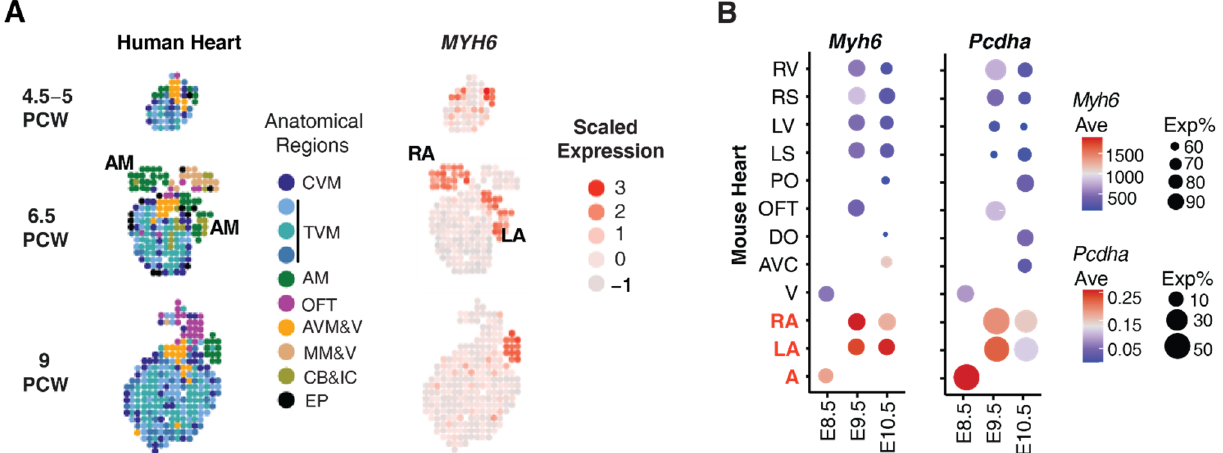
Figure 2. Atrial specific expression of MYH6 and the PCDHA gene cluster. ( A ) Spatial transcriptomic heatmap revealed abundant MYH6 expression predominantly in the atria of embryonic heart at 4.5–5, 6.5 and 9 postconceptional weeks (PCW). Heart regions color coded as shown. CVM: compact ventricular myocardium. TVM: trabecular ventricular myocardium. AM: atrial myocardium. OFT: outflow tract/large vessels. AVM&V: atrioventricular mesenchyme & valves. MM &V: mediastinal mesenchyme & vessels. CB & IC: cavities with blood and immune cells. EP: epicardium. ( B ) Atria = expression of Myh6 and Pcdha gene cluster in mouse embryonic heart. Dot size shows proportion of cells expressing Pcdha (Exp%). Color denotes average expression (Ave). A, atrium; V, ventricle; RA, right atrium; LA, left atrium; AVC, atrioventricular canal; RV, right ventricle; RS, right ventricular septum; LS, left ventricular septum; LV, left ventricle; OFT, outflow tract; PO, proximal outflow tract; DO, distal outflow tract.